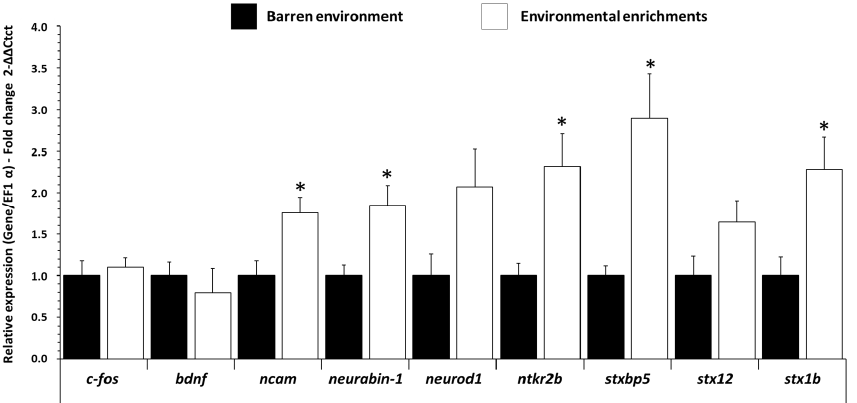
Figure 3. Neurotrophic and synaptogenesis factors related mRNA level in forebrain of trout raised in a barren environment (black) or environmental enrichments (white) for three months. Values are expressed as group mean ± SEM; fold change vs. barren environment for all genes; Welch’s t ‐ test, Tukey post hoc; differences between treatments are represented by * ( p < 0.05). Replicates (n = 8) correspond to different individual fish.